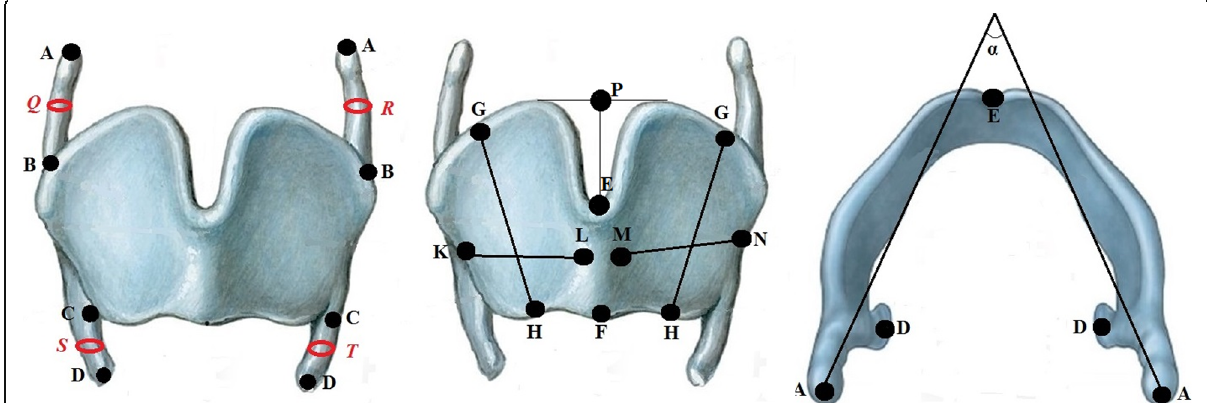
Fig. 1 Thyroid cartilage contour showing the main measurement points. a -apex of the superior horn; b -point at the base of superior horn; c - point at the base of inferior horn; d -apex of inferior horns; E-superior point of anterior intermedium line; f -inferior point of the anterior intermedium line; g -superior point of lamina middle line; h -inferior point of lamina middle line; k -point in the middle of right lamina ’ s posterior edge; l -point in the middle of right lamina ’ s anterior edge; m -point in the middle of left lamina ’ s anterior edge; n -point in the middle of left lamina ’ s posterior edge; P-middle of the line connecting the upper edge of the left and right thyroid plates; Q-middle of the right upper horn; R- middle of the left upper horn; S-middle of the right lower horn; T-middle of the left lower horn; α -thyroid angle prior to cricothyroid joint dissection and thyroid cartilage separation from other laryngeal